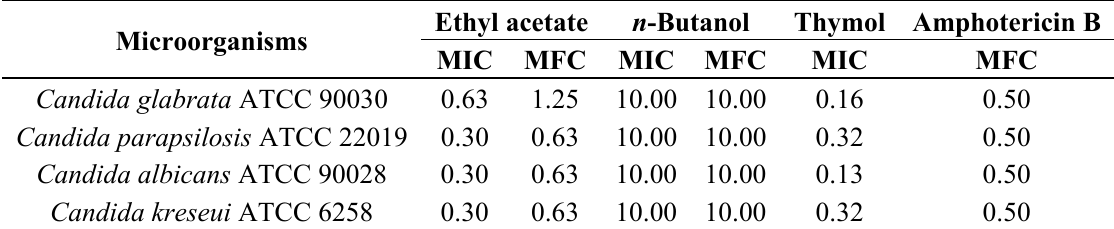
Table 6. Anticandida activity of F. lutea extracts. Ethyl acetate n -Butanol Thymol Amphotericin B Microorganisms MIC MFC MIC MFC MIC MFC Candida glabrata ATCC 90030 0.63 1.25 10.00 10.00 0.16 0.50 0.30 0.63